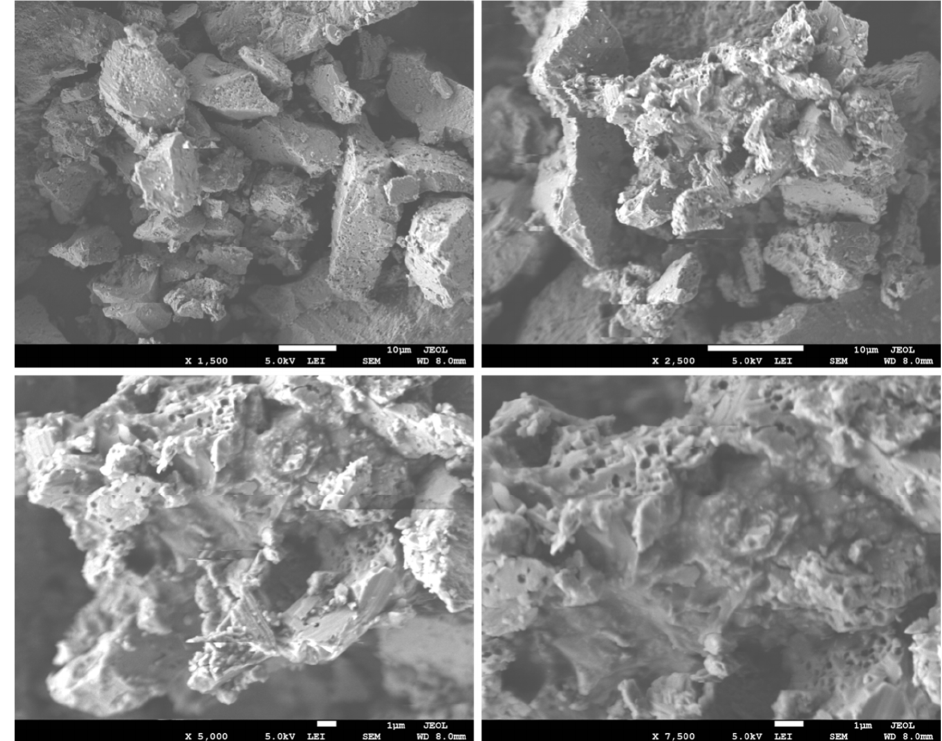
Figure 5. SEM data of egg shell biochar.